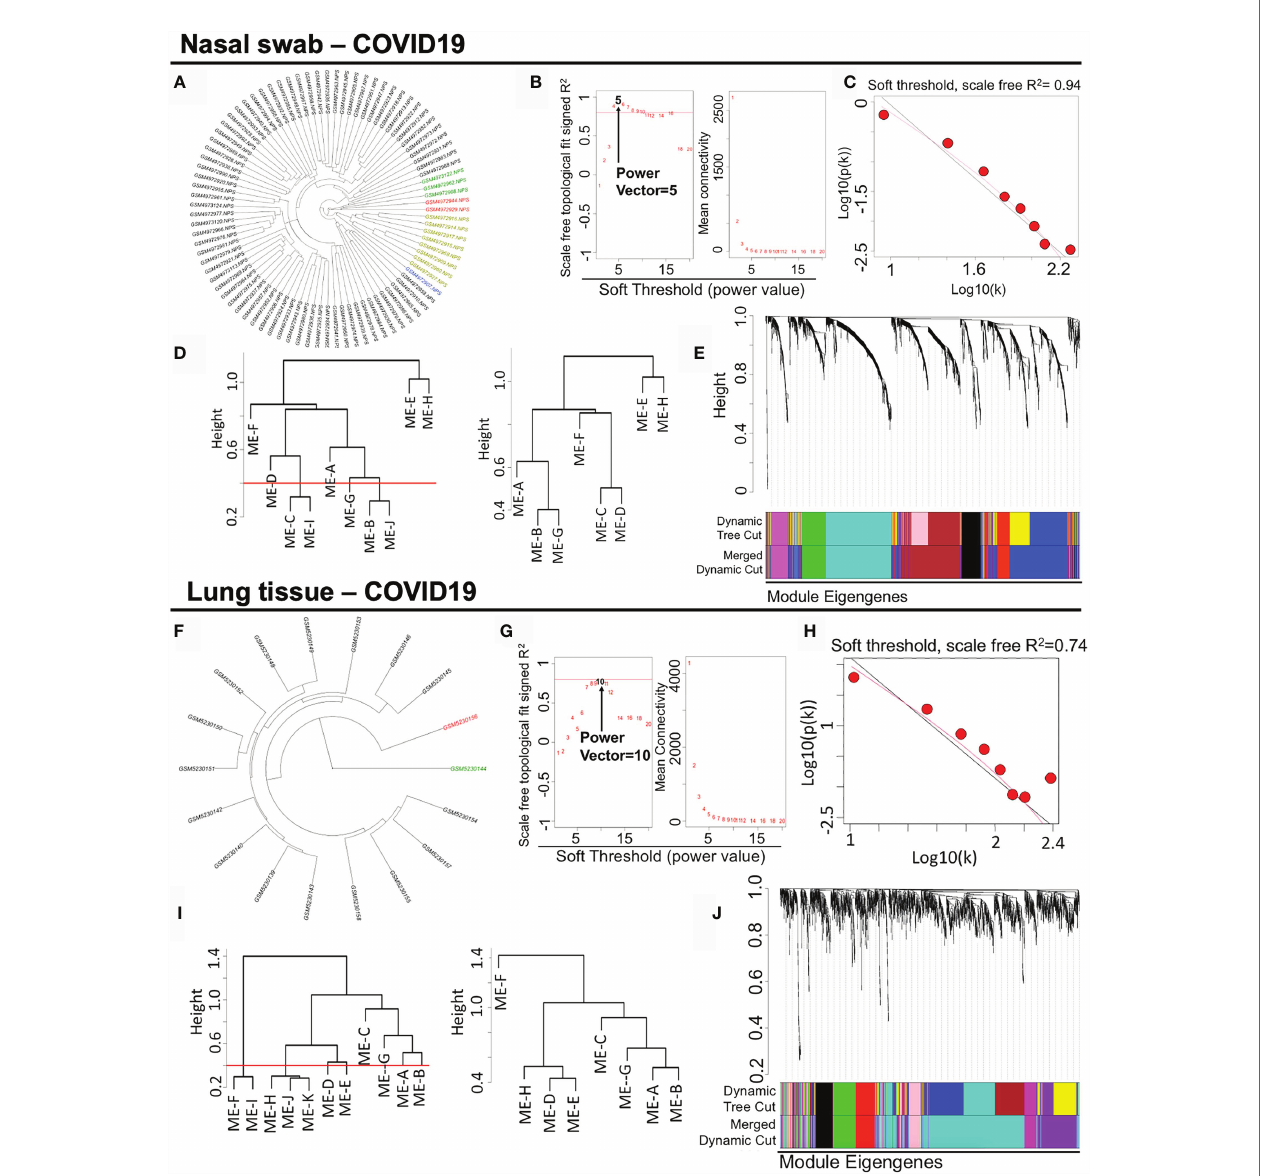
FIGURE 2 | Constructing weighted co-expression gene modules from nasopharyngeal specimen and pulmonary tissue in COVID-19. (A , F) Hierarchical clustering of genes in nasal swab and lung tissue. The coloring samples are the outliers due to the numerous missing or zero-variance expression genes. (B , G) Analysis of network topology for various soft-thresholding powers. Left panel shows the index of scale-free topology fi t (y-axis) as a function of the soft-thresholding power (x-axis). Right panel shows the value of mean connectivity (y-axis) as a function of soft-thresholding power (x-axis). (C , H) A log-log plot of connectivity of signed adjacency matrices. The x-axis stands for the logarithm of entire network connectivity, while y-axis is logarithm of related frequency distribution (D , I) Hierarchical clustering and merging of close-distance gene patterns. (E , J) A dendrogram composed of relationships among clustered gene modules with high